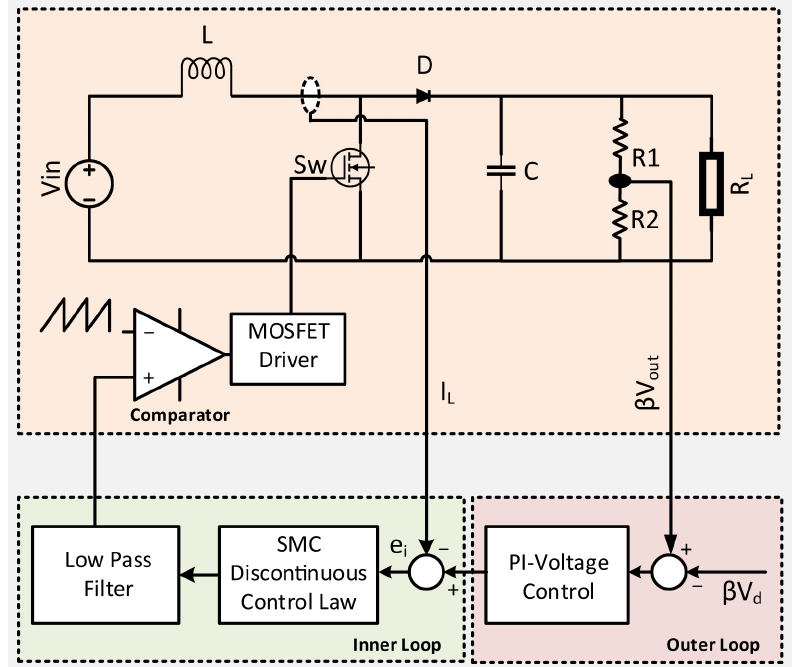
Figure 1. Block diagram of the proposed filter extracted equivalent control based sliding mode control (FEEC-SMC) for voltage regulation in boost